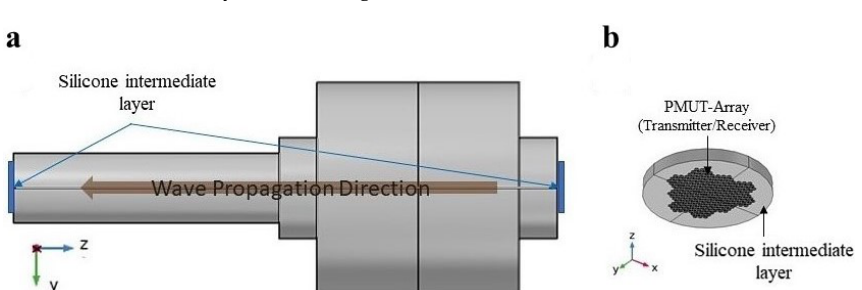
Figure 9. Pitch-Catch ultrasonic testing technique. ( a ) Direction of the pressure acoustic wave propagation along the bolts access emitted from the Transmitting PMUT array and detected by the receiving PMUT array. ( b ) PMUT array deposited on an intermediate silicone rubber